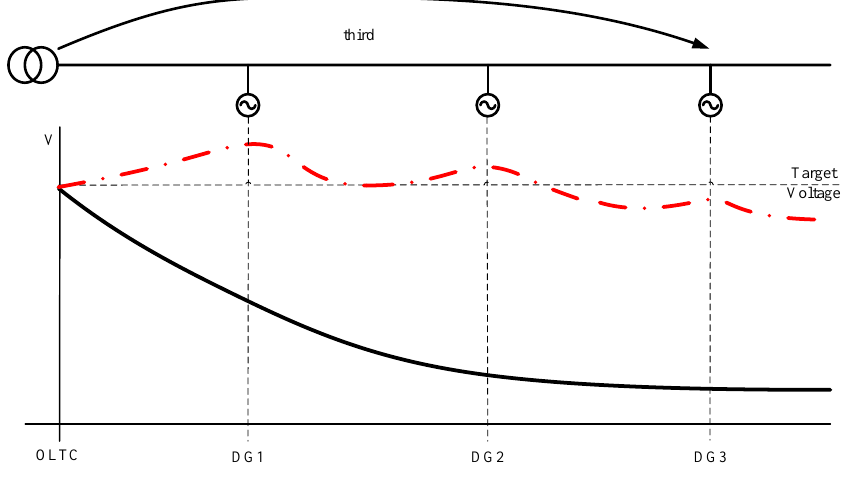
Figure 7. Voltage profile by reactive power of DG1, DG2 and DG 3.